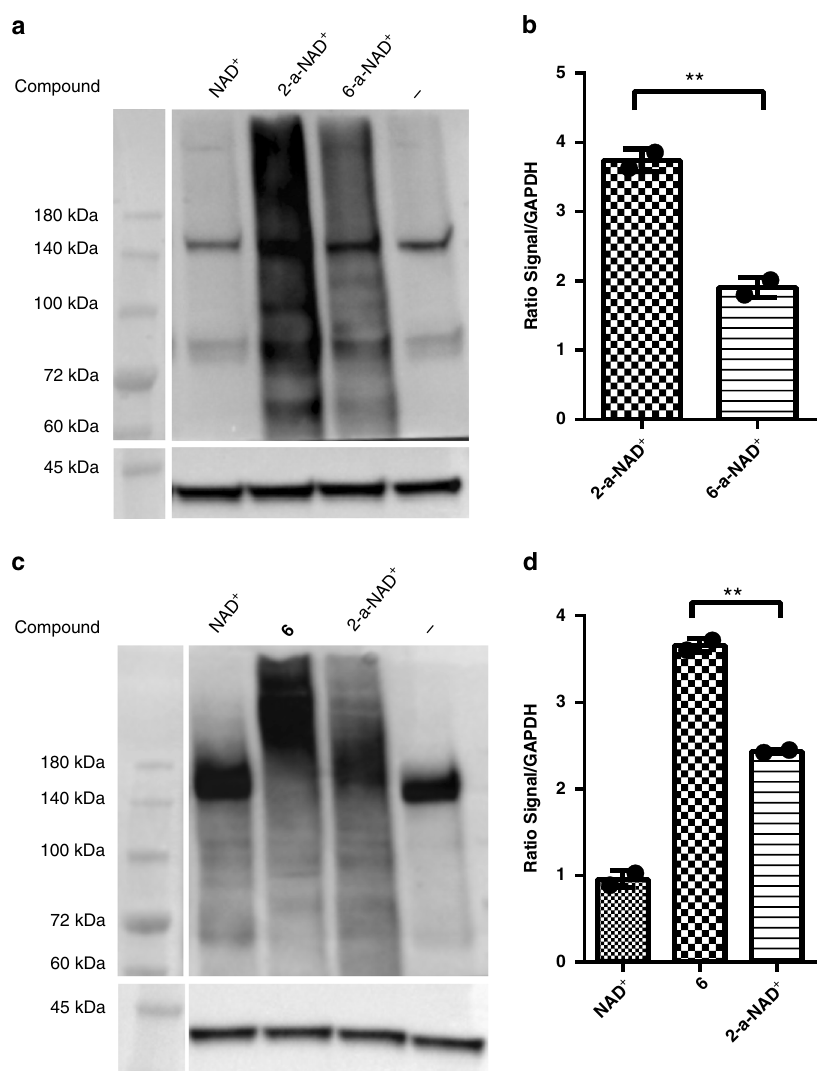
Fig. 7 Labeling of protein PARylation in cell lysates. a Immunoblot analysis of protein PARylation by 2-a-NAD + and 6-a-NAD + in HeLa cell lysates as detected by the streptavidin-HRP conjugate. GAPDH as protein loading controls were detected by the anti-GAPDH antibody. b Densitometric analysis of protein PARylation normalized to the GAPDH controls. c Immunoblot analysis of protein PARylation by NAD + , 6 , and 2-a-NAD + in HeLa cell lysates as detected by the Fc-WWE antibody. GAPDH as protein loading controls were detected by the anti-GAPDH antibody. d Densitometric analysis of protein PARylation normalized to the GAPDH controls. ** P < 0.01 by one-tailed unpaired t -test. Error bars represent standard deviation of two replicates. Source data are provided as a Source Data fi